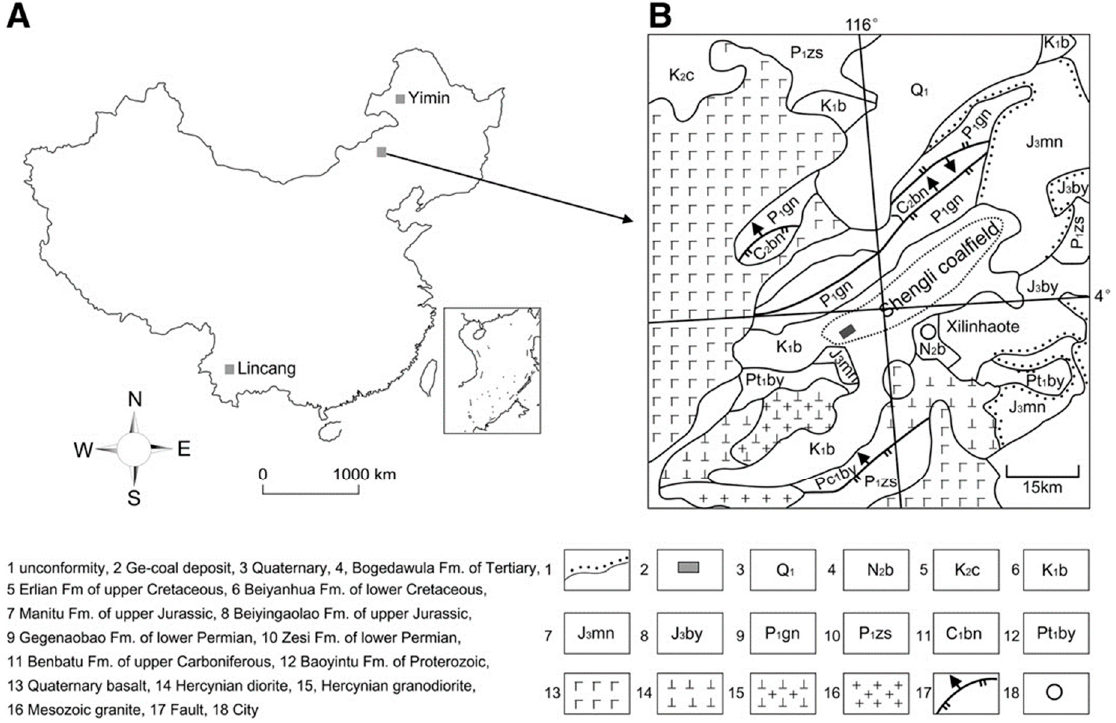
Figure 1. Geological setting of the Wulantuga high-Ge coal deposit [10,21]. ( A ): Location of the